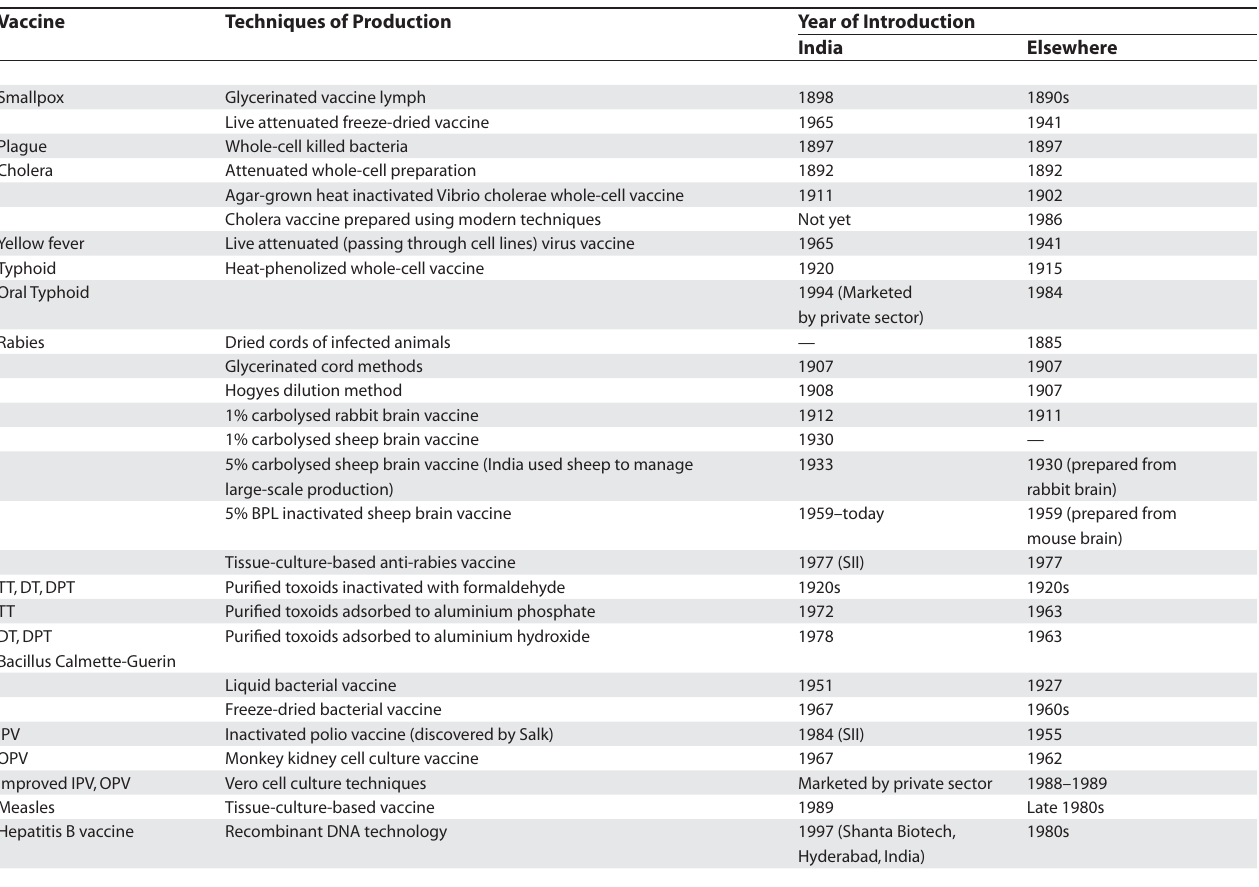
Table 1. The Introduction of Vaccine Technologies in India and Elsewhere in the World Vaccine Techniques of